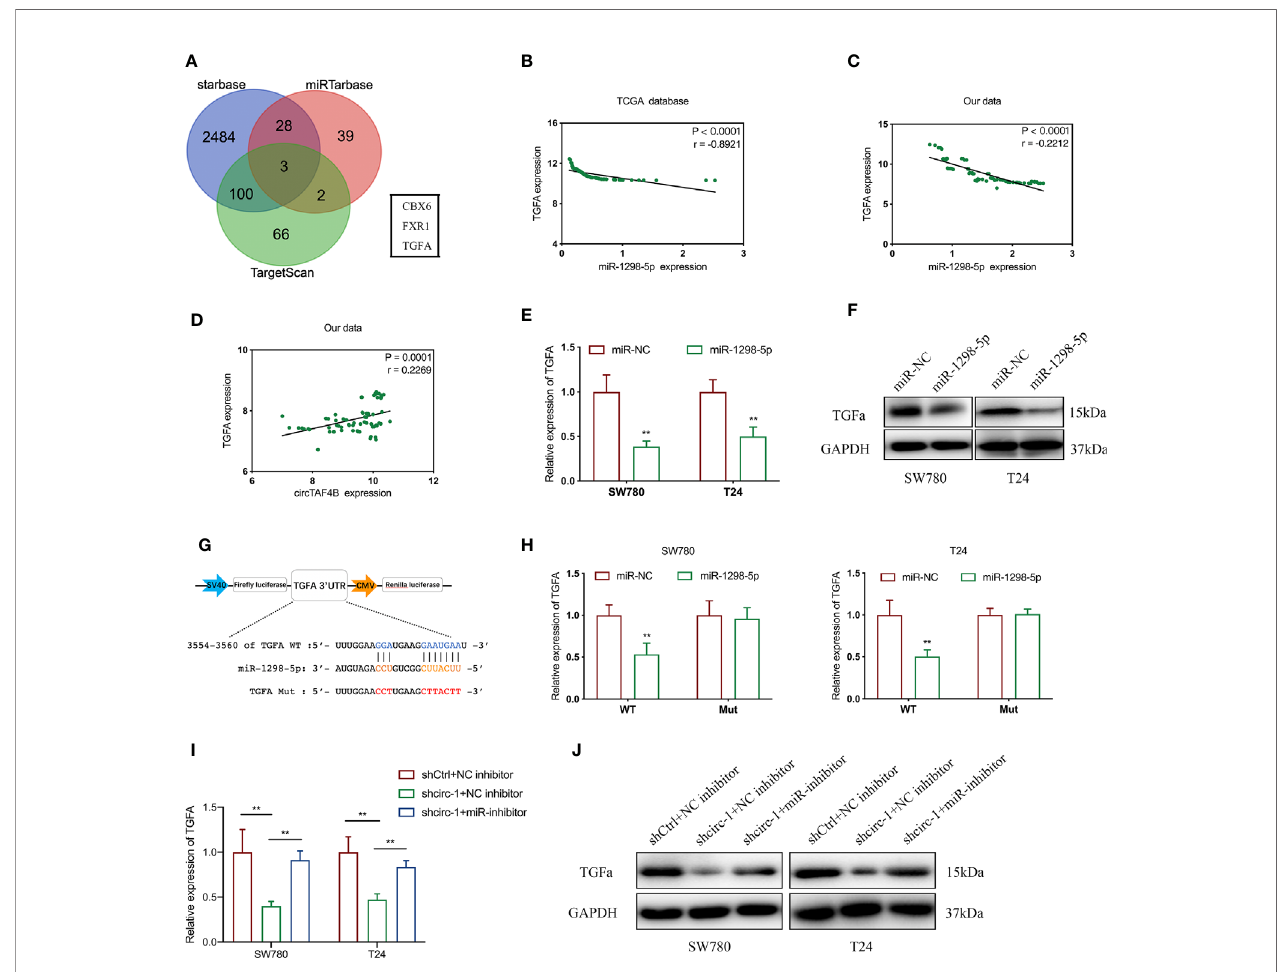
FIGURE 5 | 5circTAF4B positively regulates TGFA by sponging miR-1298-5p. (A) Venn diagram analysis of miR-1298-5p target genes by using three databases. (B, C) The TCGA database and our data showed that miR-1298-5p expression was negatively correlated with TGFA expression in BCa tissues. (D) Our data showed that circTAF4B expression was positively correlated with TGFA expression in Bca tissues. (E, F) Overexpression of miR-1298-5p decreased the expression of TGFA at both the mRNA and protein levels. (G) Schematic diagram of a dual-luciferase reporter plasmid constructed by TGFA sequence complementation with miR-1298-5p. (H) Dual-luciferase assay showed that miR-1298-5p reduced the luciferase activity of the vector containing wild-type TGFA. (I, J) Inhibition of miR- 1298-5p reversed the mRNA and protein expression of TGFA suppression by circTAF4B knockdown. Data represent the mean ± SD of more than three independent experiments. *p < 0.05; **p <